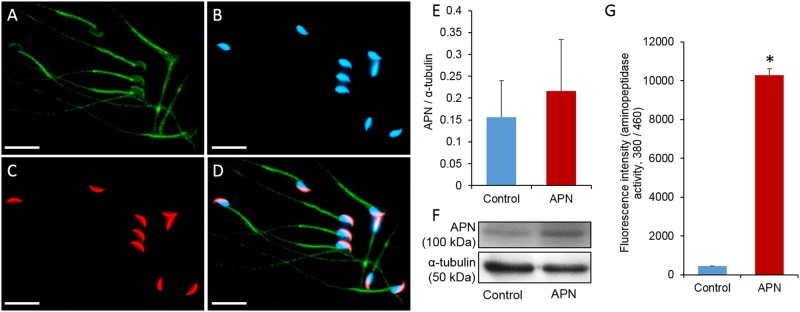
Localization of APN in spermatozoa and the effect of recombinant APN (20 ng/mL) on APN level and its enzymatic activity in mouse spermatozoa.(A) Localization of APN (green). (B) Location of nucleus (Hoechst 33258, blue). (C) Location of the acrosome (lectin PNA, red). (D) Merged location of the nucleus, acrosome, and APN. Images were obtained using the Nikon TS-1000 microscope and NIS-Elements imaging software (Nikon, Japan). Bar = 20 μm. (E) Quantification of APN in spermatozoa. (F) Representative image of western blot showing the band (~100 kDa) corresponding to APN in the spermatozoa (P = 0.234). (G) Enzymatic activity of APN in the control and treated groups (P = 0.00001). Data represent the mean ± SEM of three replicates. *P < 0.05, calculated using two-tailed Student’s t-test.